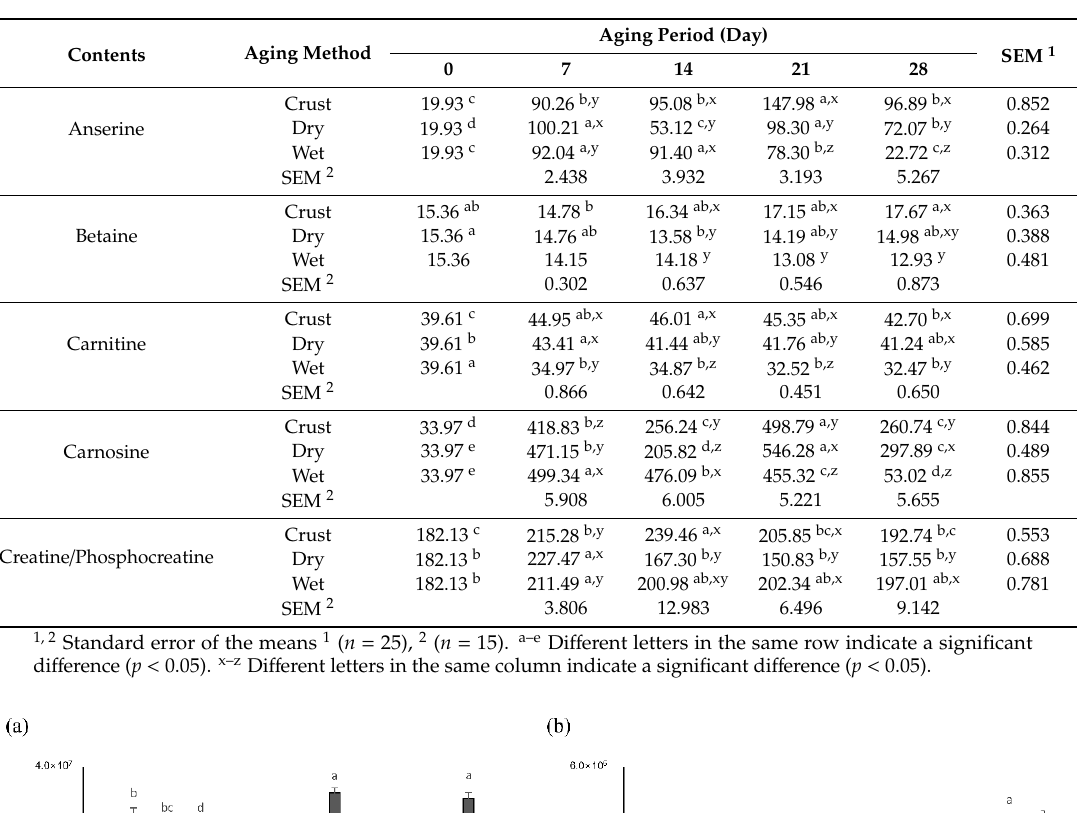
Table 2. Bioactive compounds (mg / 100 g) from di ff erent aged beef striploin ( longissimus lumborum ) using 1 H- 13 C HSQC on 850 MHz cryo-NMR spectrometer.